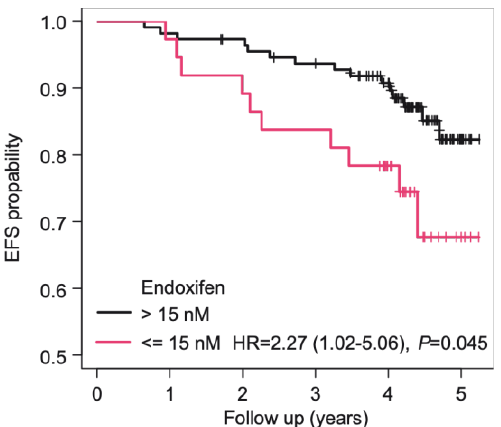
Figure 1. Kaplan – Meier curves of (Z)-endoxifen stratified by a putative threshold of 15 nM. The hazard ratio and 95% confidence intervals for below versus above threshold are given in brackets. Table 2. Multivariate Cox proportional-hazard model of dichotomized (Z)-endoxifen and stage.